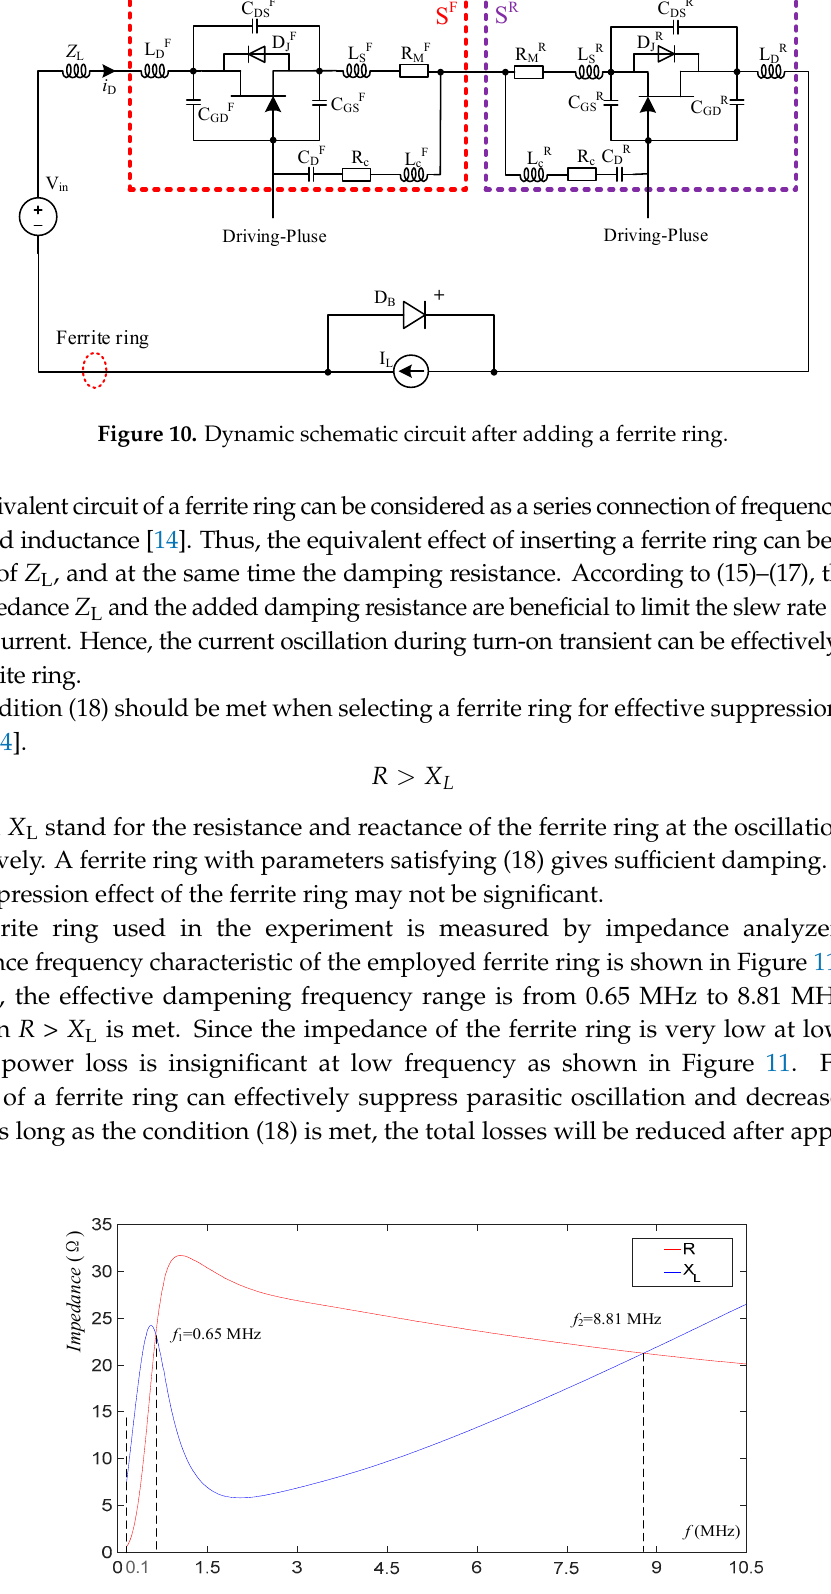
Figure 10. Dynamic schematic circuit after adding a ferrite ring.